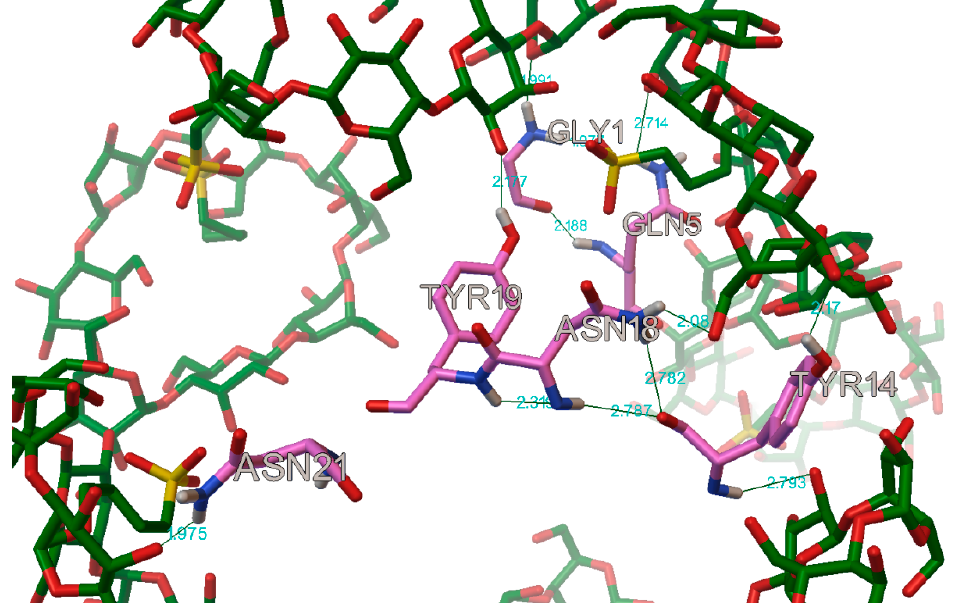
Figure 16. The most commonly occurring hydrogen bond on the A chain in the insulin molecule (in this case with the sulfobutylether- β -cyclodextrin, DS 2).